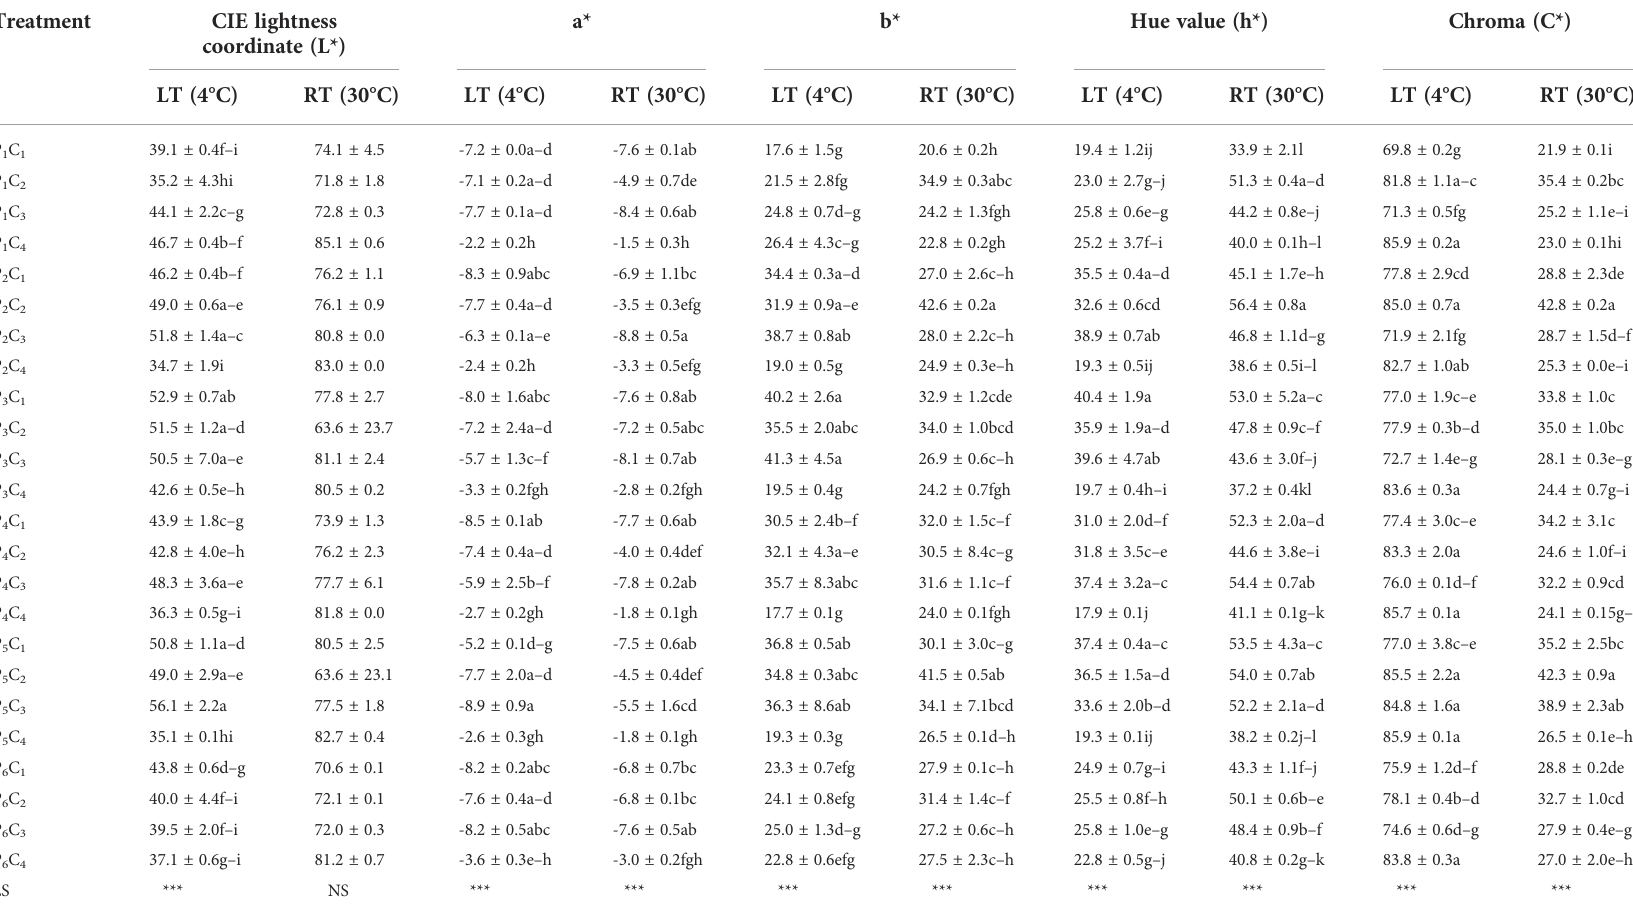
TABLE 3 Commission Internationale de I ’ Eclairage color parameters of pointed gourd up to acceptance level under different postharvest treatment and packaging conditions.